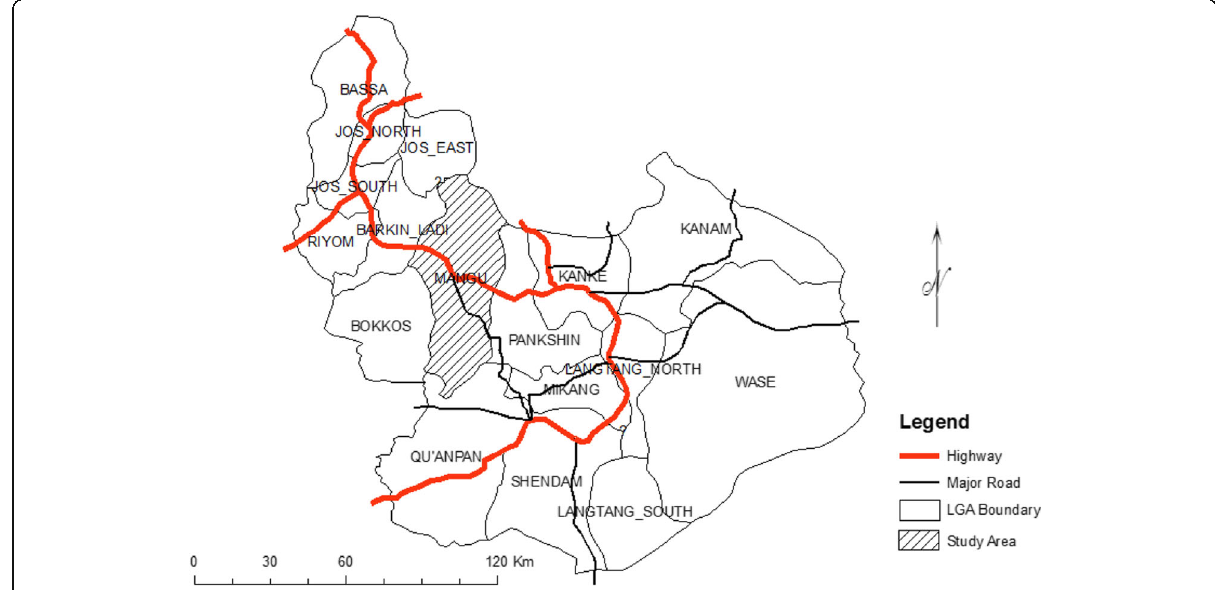
Fig. 1 Map of plateau state showing study